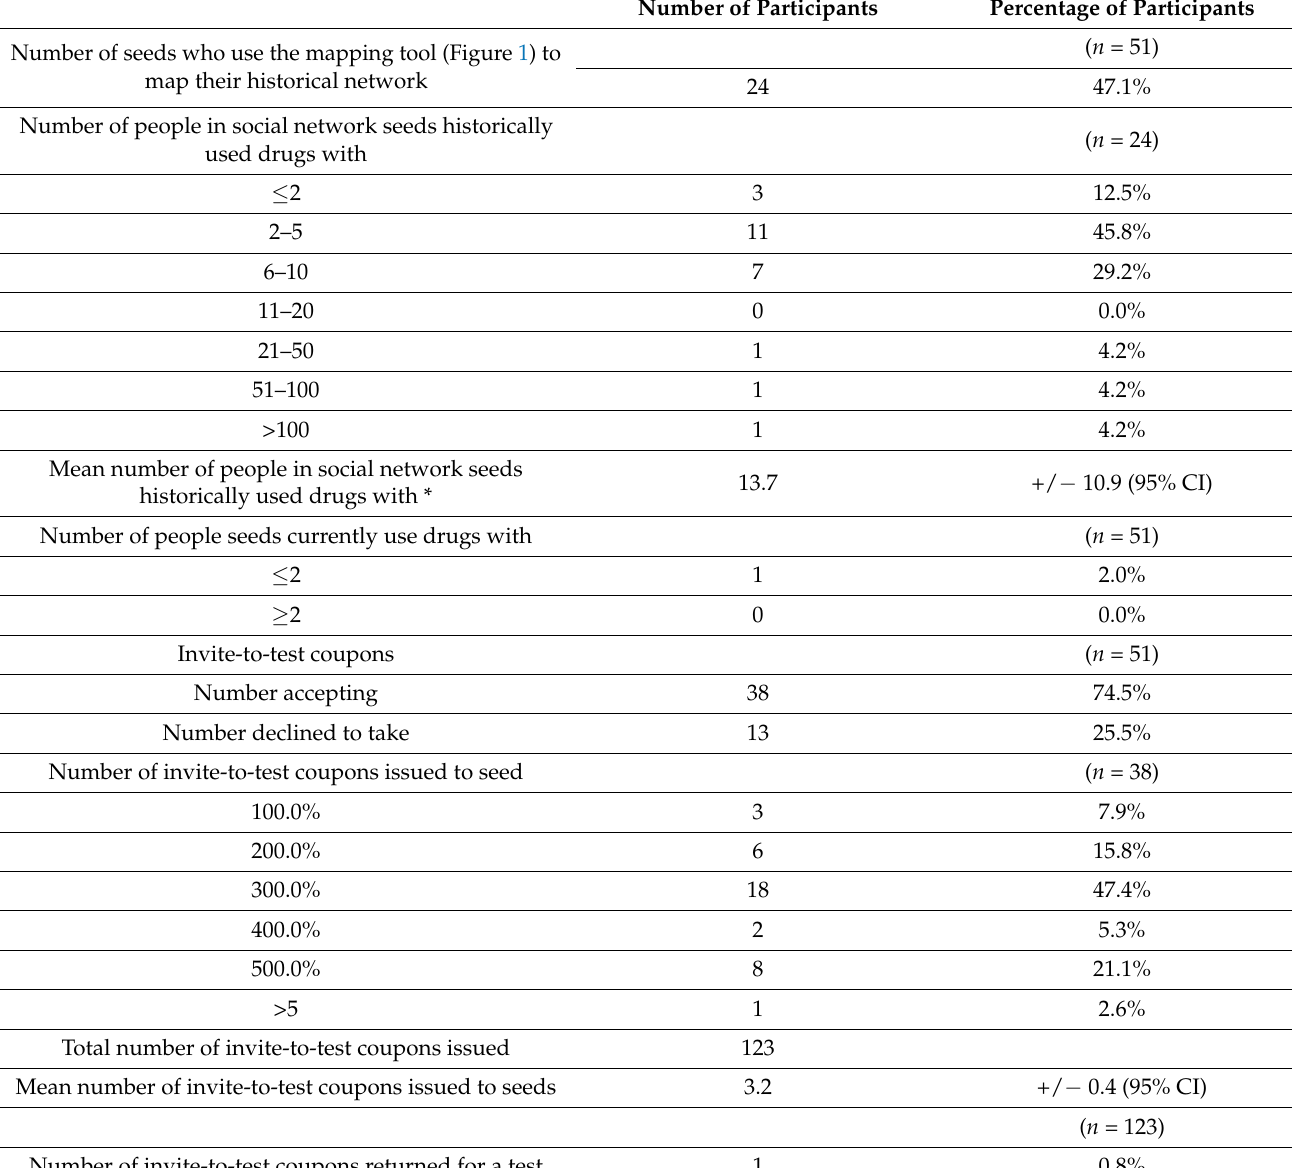
Table 2. Network and invite-to-test